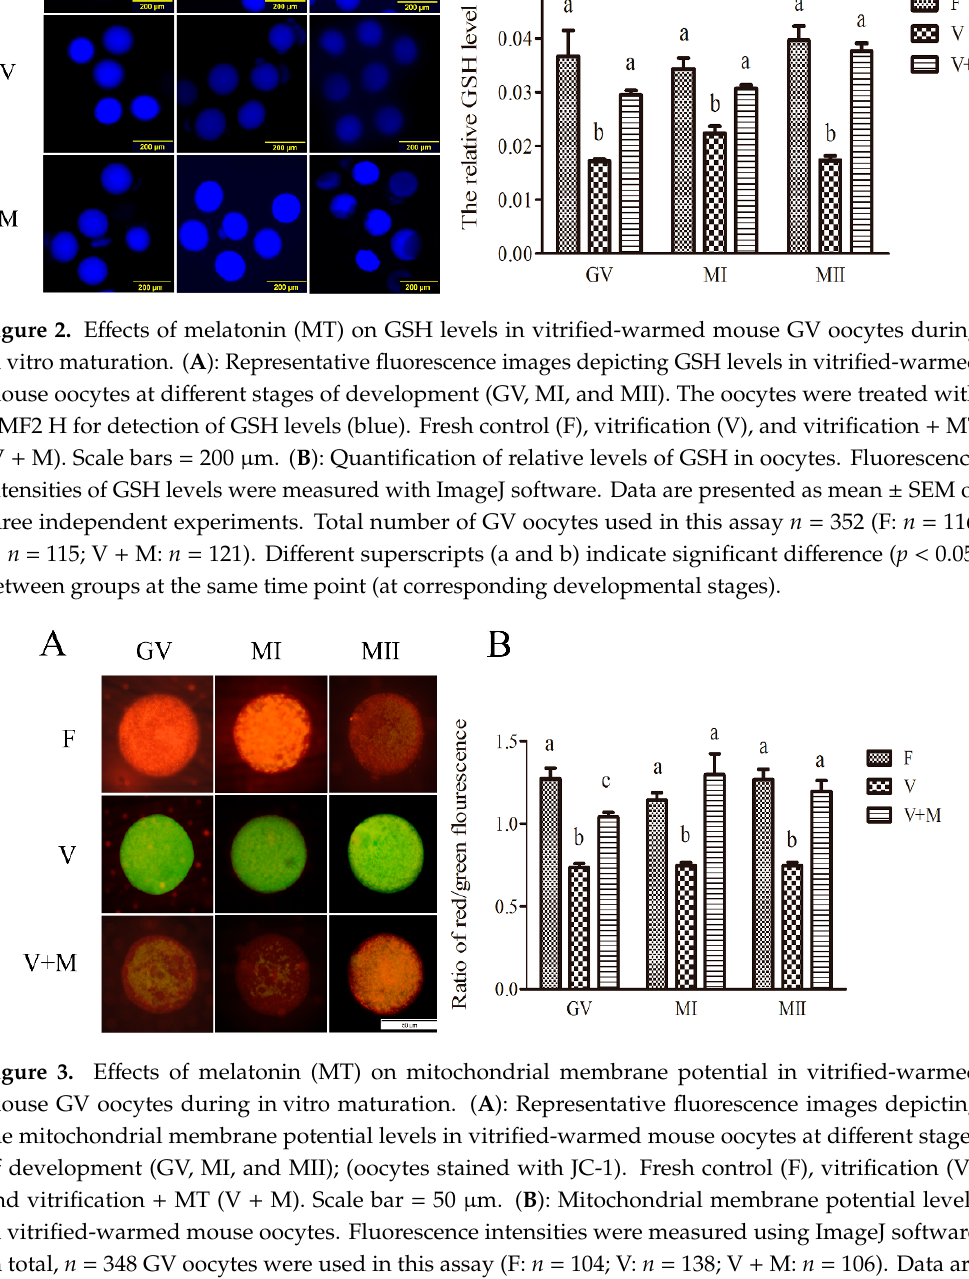
Figure 2. Effects of melatonin (MT) on GSH levels in vitrified-warmed mouse GV oocytes during in vitro maturation. ( A ): Representative fluorescence images depicting GSH levels in vitrified-warmed mouse oocytes at different stages of development (GV, MI, and MII). The oocytes were treated with CMF2 H for detection of GSH levels (blue). Fresh control (F), vitrification (V), and vitrification + MT (V + M). Scale bars = 200 µm. ( B ): Quantification of relative levels of GSH in oocytes. Fluorescence intensities of GSH levels were measured with ImageJ software. Data are presented as mean ± SEM of three independent experiments. Total number of GV oocytes used in this assay n = 352 (F: n = 116; V: n = 115; V + M: n = 121). Different superscripts (a, b, and c) indicate significant difference ( p < 0.05) between groups at the same time point (at corresponding developmental stages).